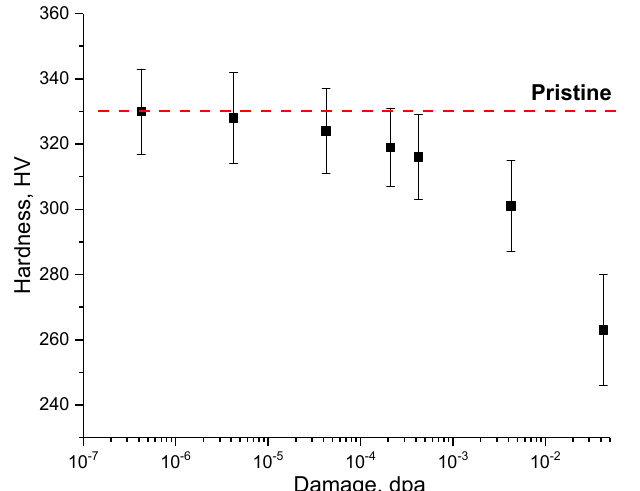
Figure 8. Results of changes in hardness depending on the value of atomic displacements upon irradiation with heavy Kr 15+ ions (data are presented on a logarithmic scale).